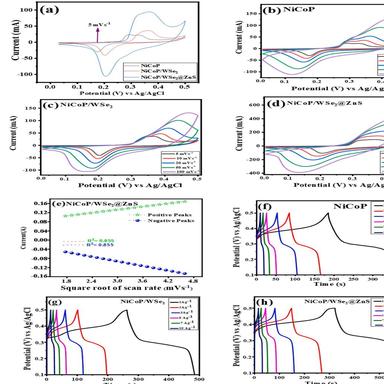
Electrochemical performance of the as-made electrodes for supercapacitors in three- electrode system. (a) CV curves of as-made three electrodes at a scan rate of 5mVs− 1 . CV Curves of (b) NiCoP (c) NiCoP/WSe2 and (d) NiCoP/WSe2/ZnS. (e) plots of anodic and corresponding cathodic peak. GCD curves of (f) NiCoP (g) NiCoP/WSe2 and (h) NiCoP/WSe2/ZnS.